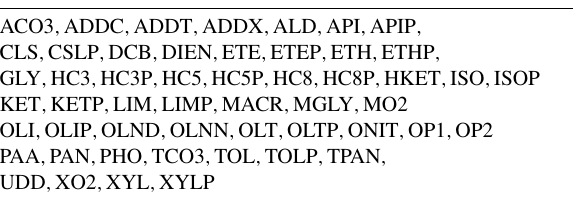
Table 3. Initial conditions for the FLUX and STRATO test